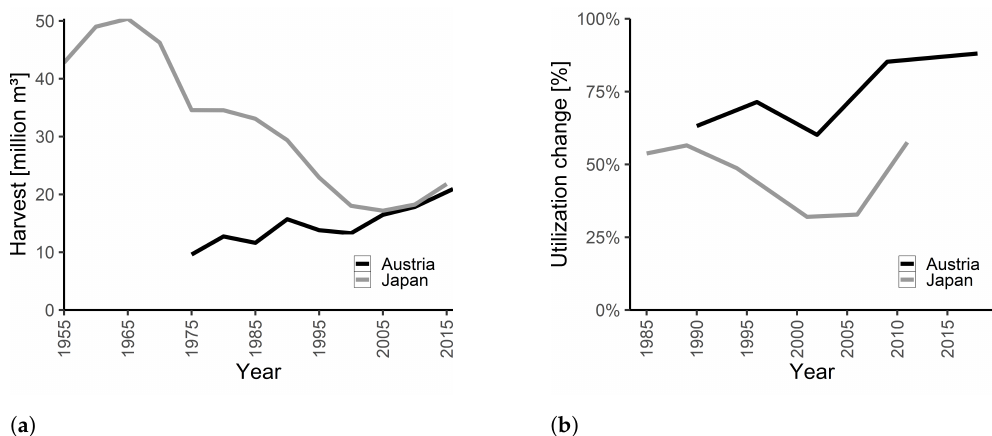
Figure 5. The total harvest ( a ) and forest utilization percentage (harvest divided by increment) ( b ) according to data from the Austrian National Forest Inventory (1996, 2002, 2009, 2018) and Forest Agency (2019a,